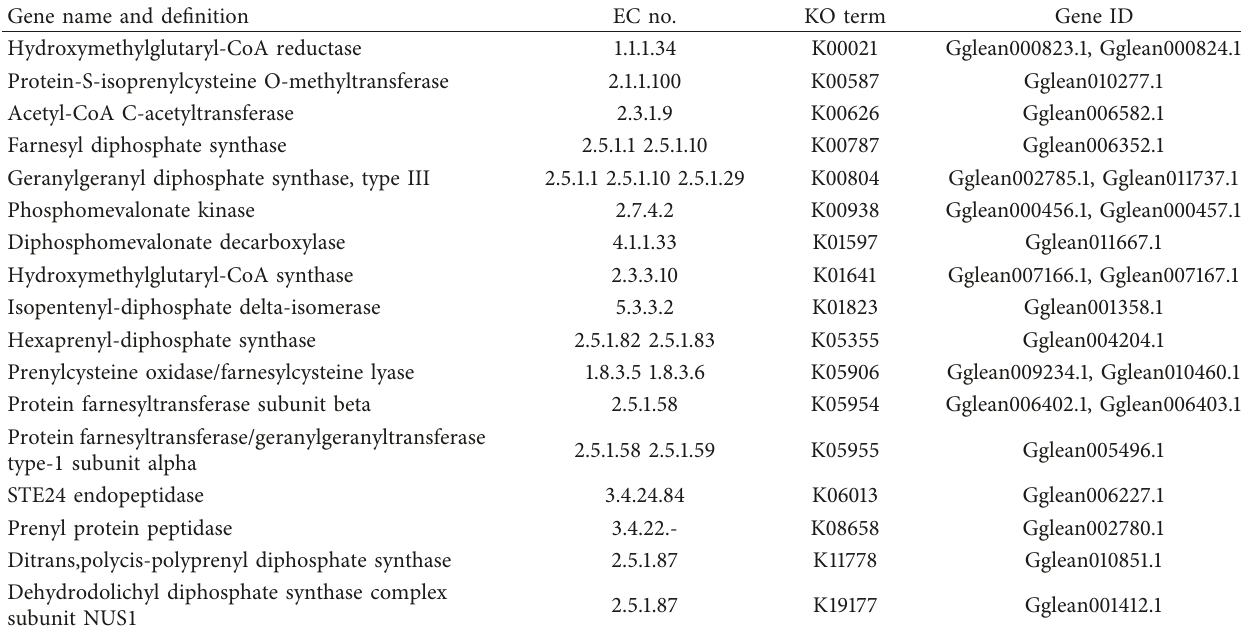
Table 4: A list of putative genes involved in terpenoid backbone